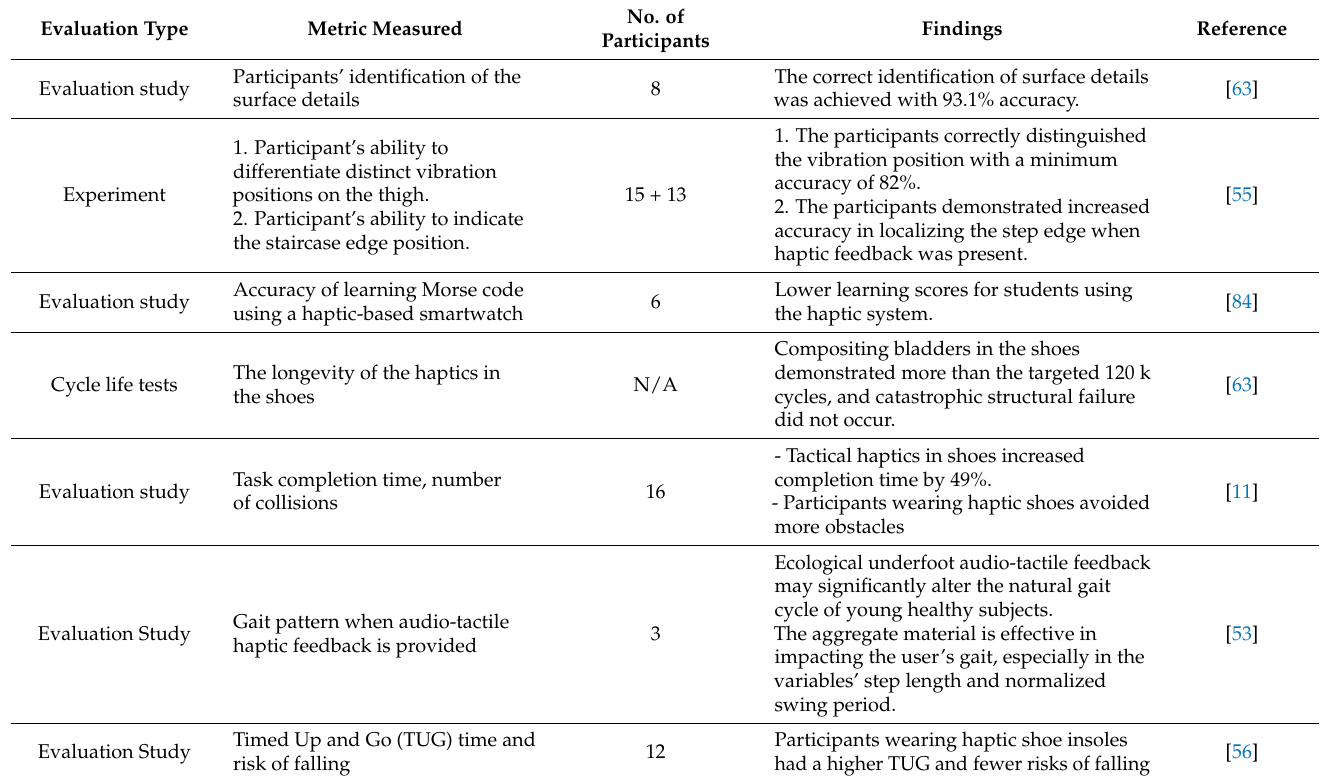
Table 6. An overview of the quantitative evaluation of the surveyed haptic